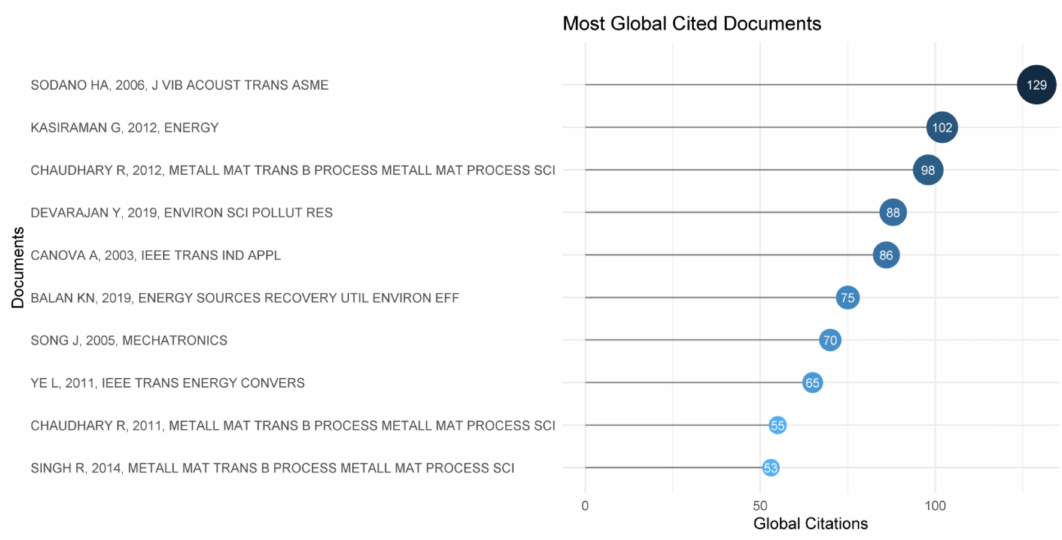
Figure 5. Most global cited